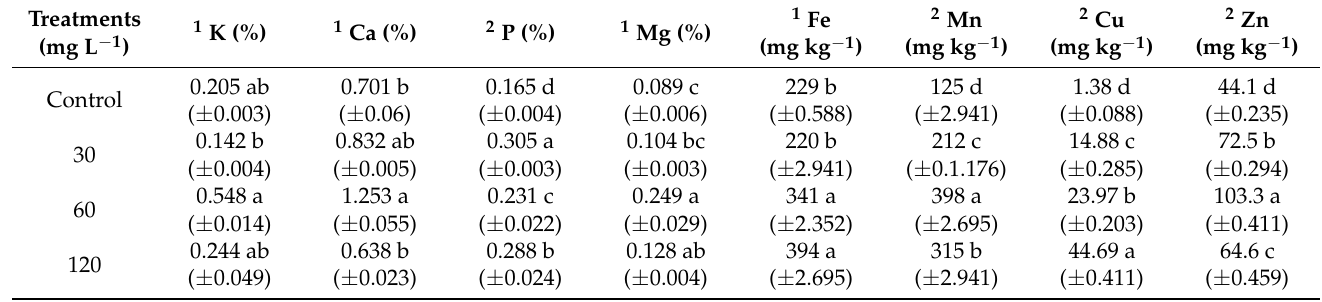
Values are the mean ± SE and values followed by the same letters in the same column were not significantly different by 1 Kruskal–Wallis Test and 2 Duncan’s test at 0.05 level Control = 0.025 mg L − 1 and represents the concentration of CuSO 4 5H 2 O in MS medium (without copper sulphate supplementation). Table 5. Effect of different concentrations of copper sulphate on mineral content of acclimatized banana plants after 4 weeks. Treatments